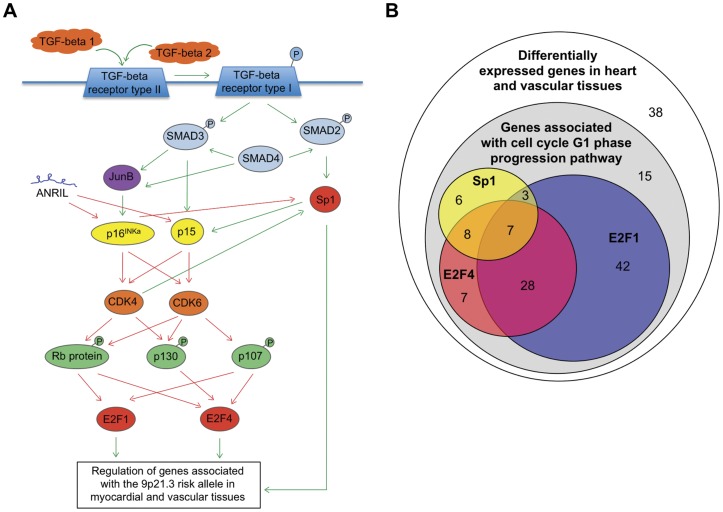
Canonical pathway modeling of the most significantly differentially expressed genes in donor heart (n = 108), carotid plaque (n = 106), aorta (n = 104) and mammary artery (n = 88) tissues.(A) A schematic depicting part of the cell cycle G1 phase progression pathway, indicating the regulatory role of p16INK4 and p15, which are encoded by two genes located adjacent to the 9p21.3 risk locus (CDKN2A and CDKN2B). The majority of the most significantly differentially expressed genes (fold-change >1.1 per copy of the risk allele, p<0.01 not corrected for multiple comparisons,) associated with the 9p21.3 risk allele in myocardial and vascular tissues were predicted to be transcriptionally regulated by this pathway, predominantly by the transcription factors E2F1, E2F4 and Sp1 (116 out of 154 genes, see Table S2 for the list of genes associated with this pathway and Figure S2 for gene network analysis). More than half of these genes (58%) were down-regulated in association with the 9p21.3 risk allele, which would be concordant with lower levels of ANRIL expression. Green arrows indicate positive regulation; red arrows indicate negative regulation. (B) Venn diagram indicating the proportion of differentially expressed genes predicted to be regulated by E2F1, E2F4 and Sp1. The genes predicted to be regulated by each of these transcription factors is indicated by the symbols *, § and ¶ respectively, in Table S2.